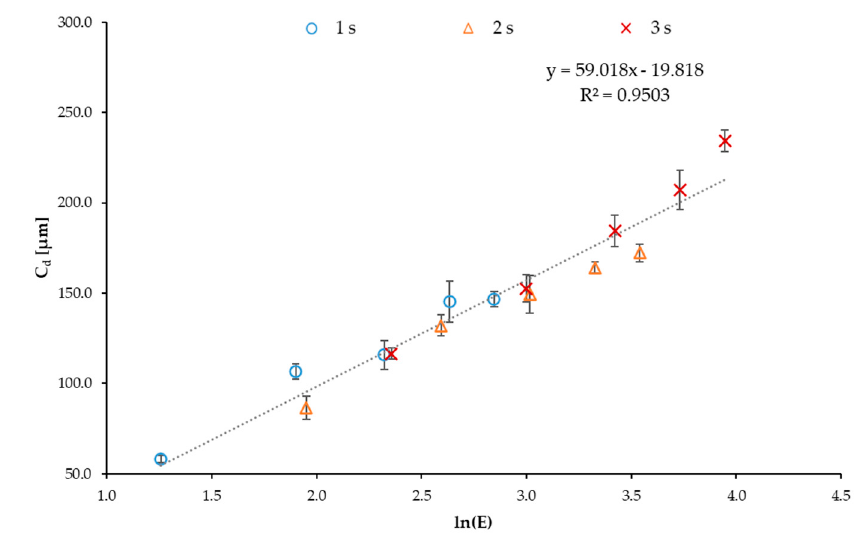
Figure 8. Cure depth values of the slurry at different exposure powers and times.